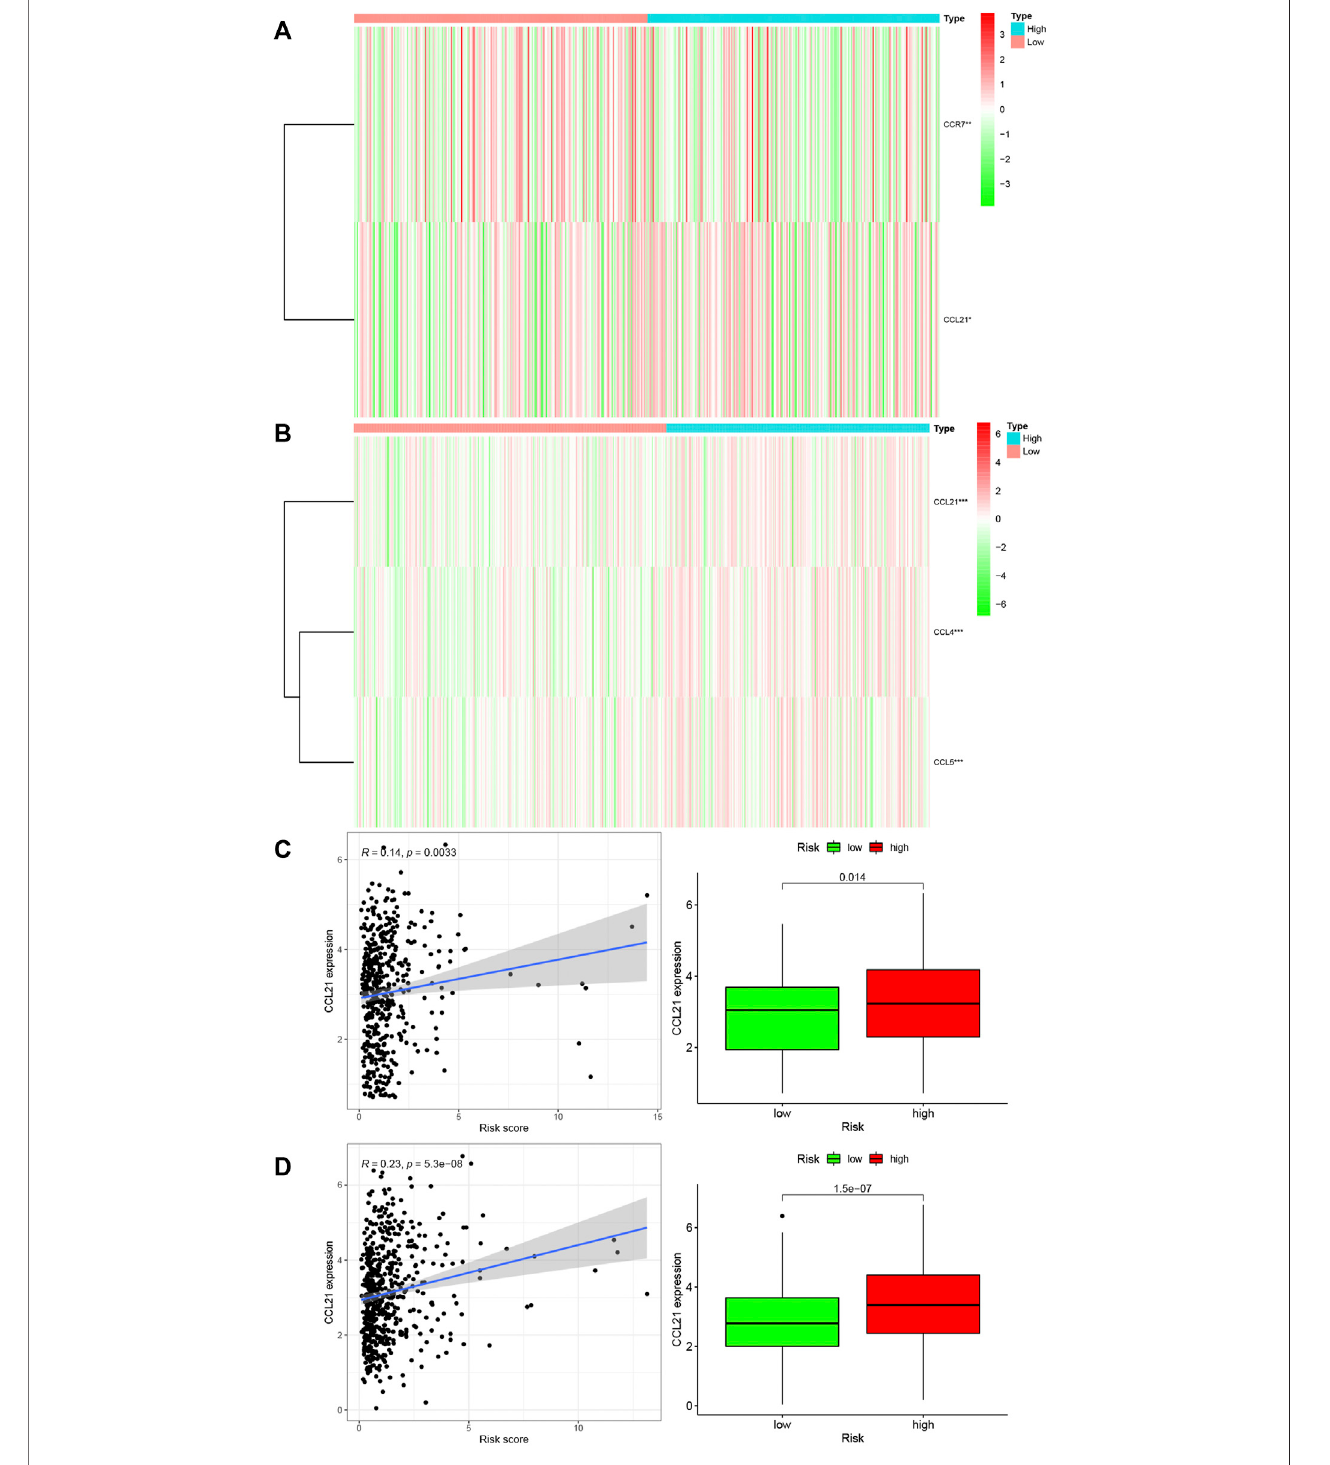
FIGURE 7 | Relationship between immune cell regulatory genes and risk scores of genes associated with in fl ammatory response. (A,B) Heat maps of the expression of genes signi fi cantly related to immune cell regulation in different risk groups in TCGA and GEO databases (* p < 0.05; ** p < 0.01; *** p < 0.001). (C,D) CorrelationbetweenCCL21genesigni fi cantlyassociatedwithimmunecellregulationandriskscoreintheTCGAandGEOdatabases.Thebluelineinthe fi gure fi ttedthe linear model between gene expression and risk score of genes related to in fl ammatory response, and Pearson ’ s coef fi cient was used to test the correlation. Box chart showed the difference in CCL21 gene expression between groups with high and low risk of in fl ammatory response related genes ( p < 0.05).